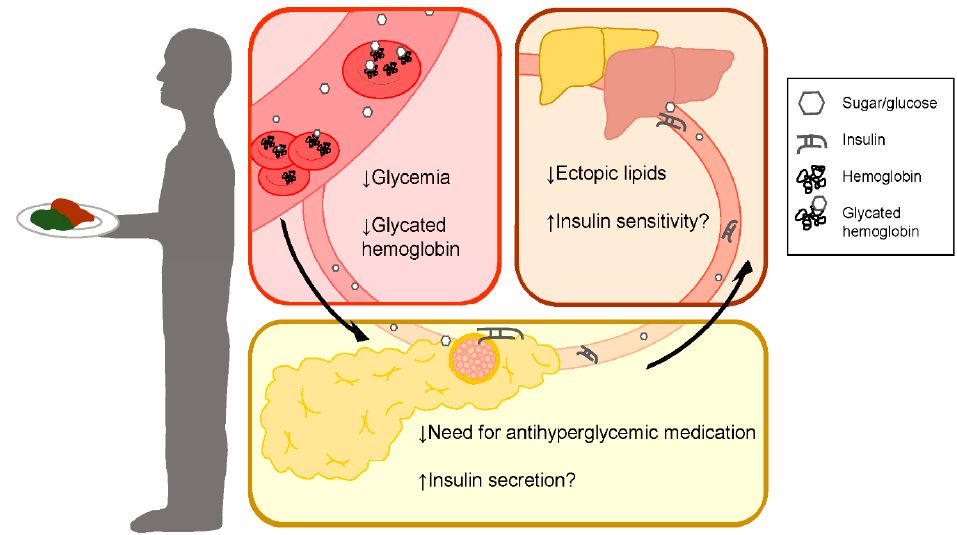
may improve insulin sensitivity through restored insulin secretion in some